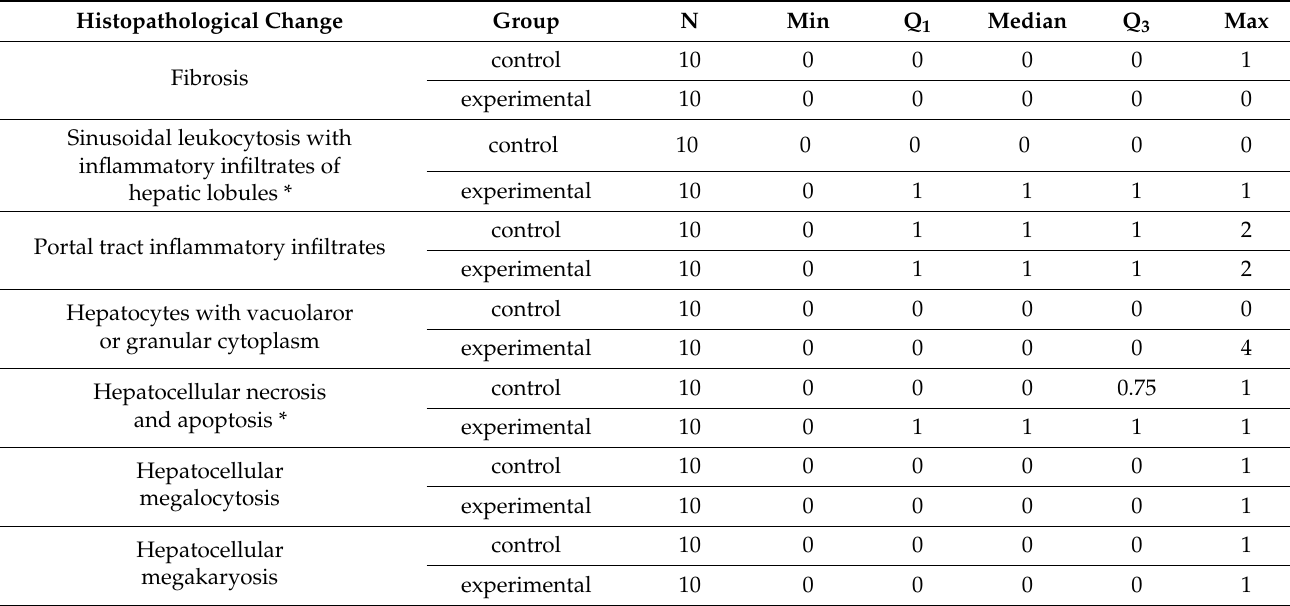
Table 1. The final scores for each histopathological change in the liver of control and experimental gilts presented with basic descriptive statistics.